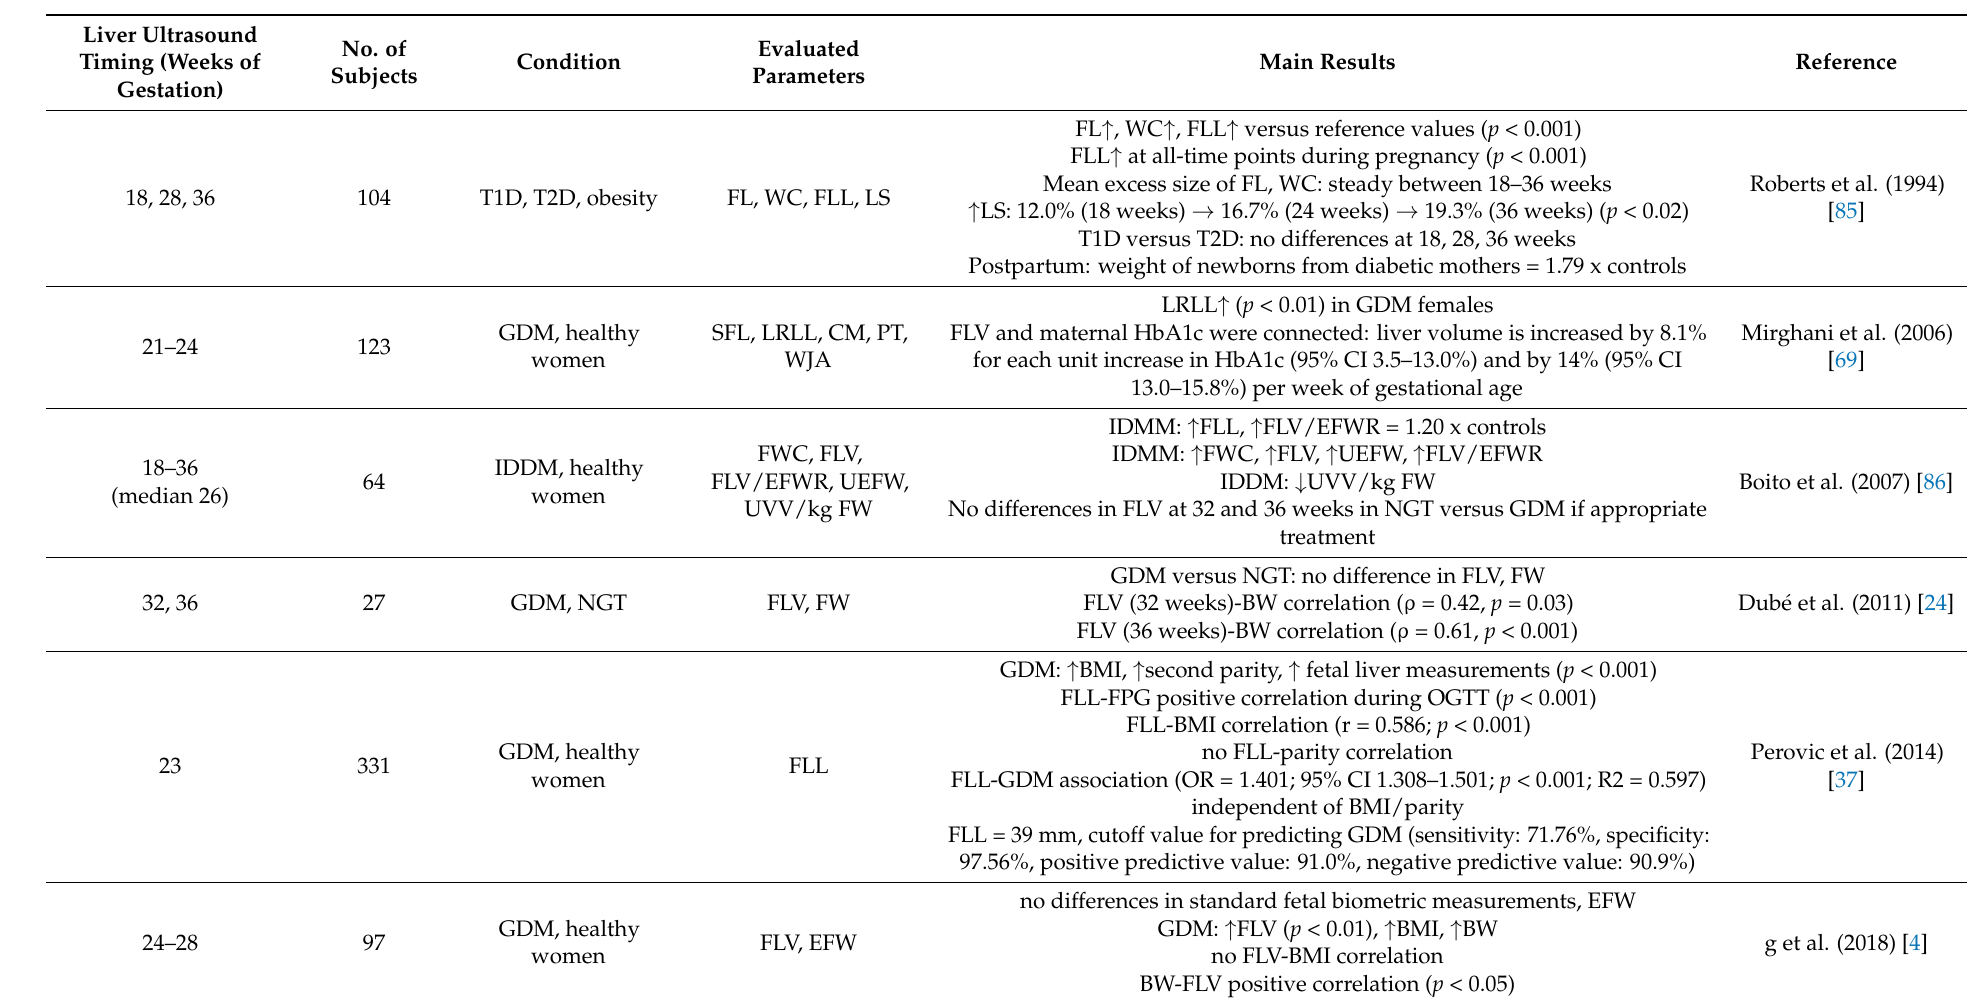
Table 1. Fetal liver-related parameters evaluated by obstetric